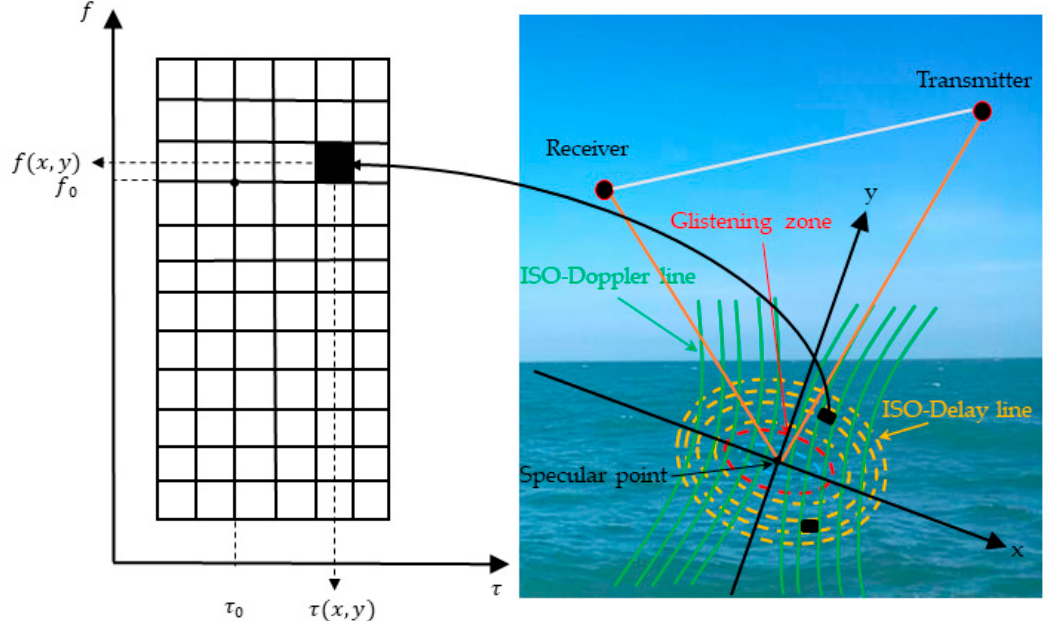
Figure 1. The corresponding relation between reflector unit and delay-Doppler unit.